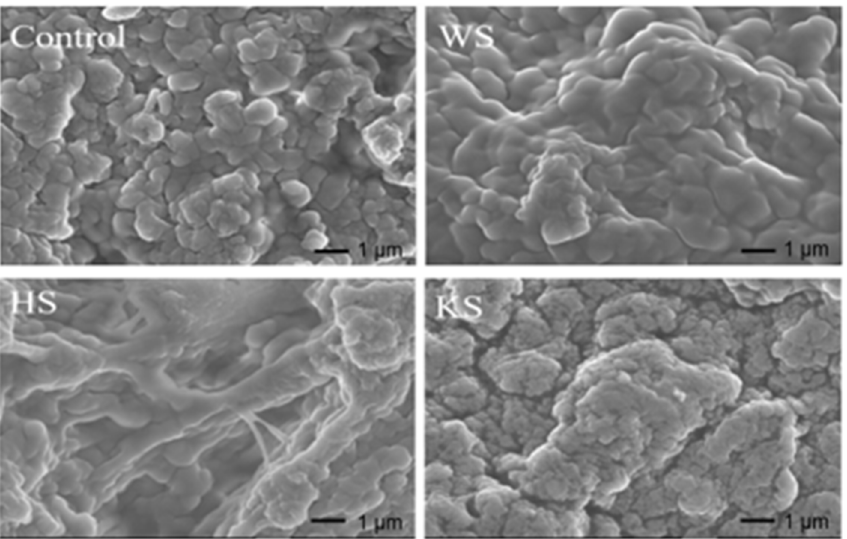
Figure 3. SEM images of surimi gel (10.0 k) with different treatments. Control: Surimi (75%) + water (25%); WS: Surimi (75%) + wakame slurry (25%); HS: Surimi (75%) + hijiki slurry (25%); KS: Surimi (75%) + kelp slurry